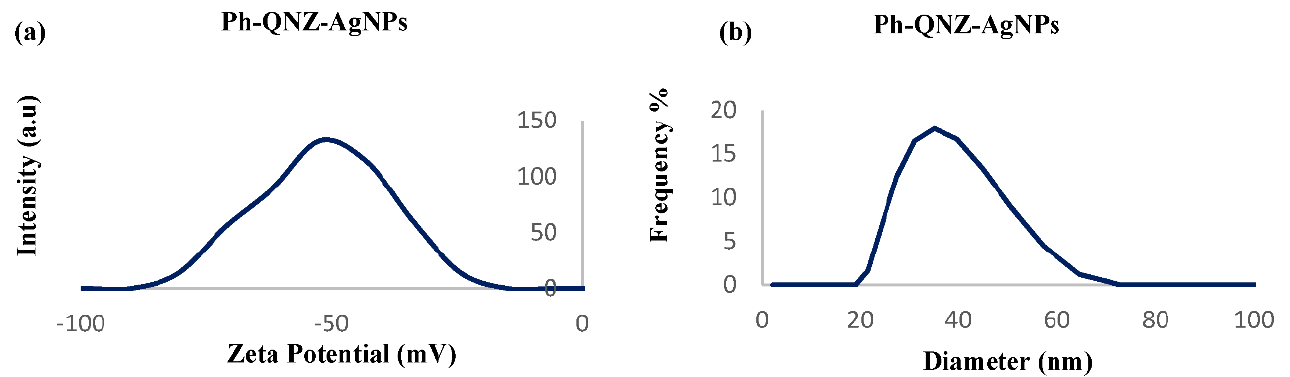
Figure 5. Representative ( a ) zeta potential plot and ( b ) size distribution histogram of 3-amino-2- phenyl-4(3 H )-quinazolinone-AgNPs ( 9-np ) obtained using a Horiba Scientific Nanoparticle Analyzer SZ-100 (all nanoparticles had mean diameters between 25 and 278 nm and a negative surface charge). Table 1. Average sizes and zeta potentials for the 12 AgNPs.